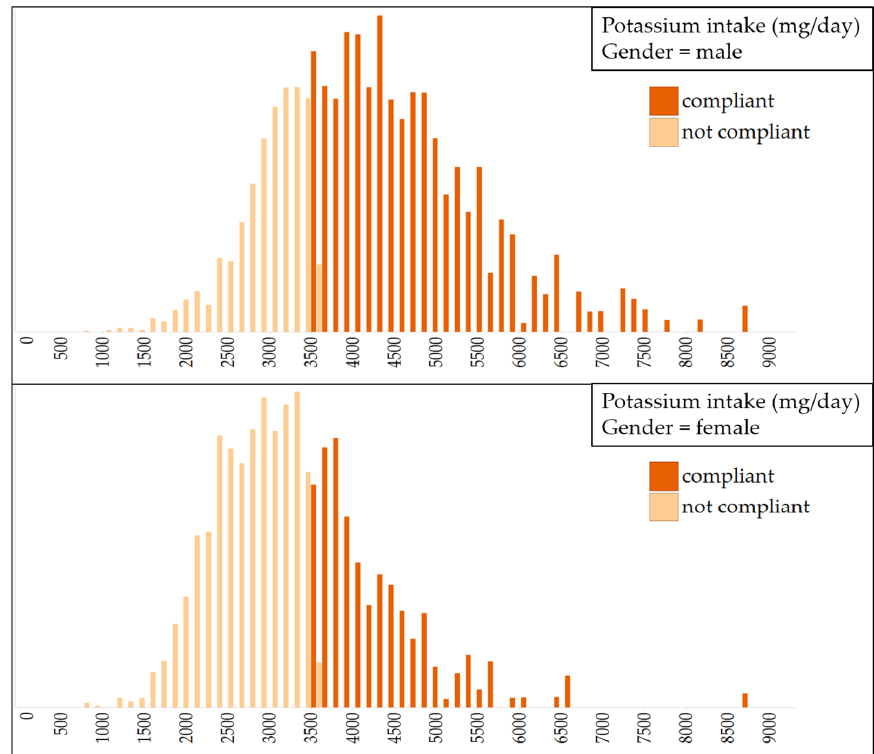
Figure 2. Baseline potassium intake in Dutch adult men and women (light bars represents proportion of population not compliant to the WHO guideline (3510 mg/day for both genders); dark bars represents the compliant proportion.